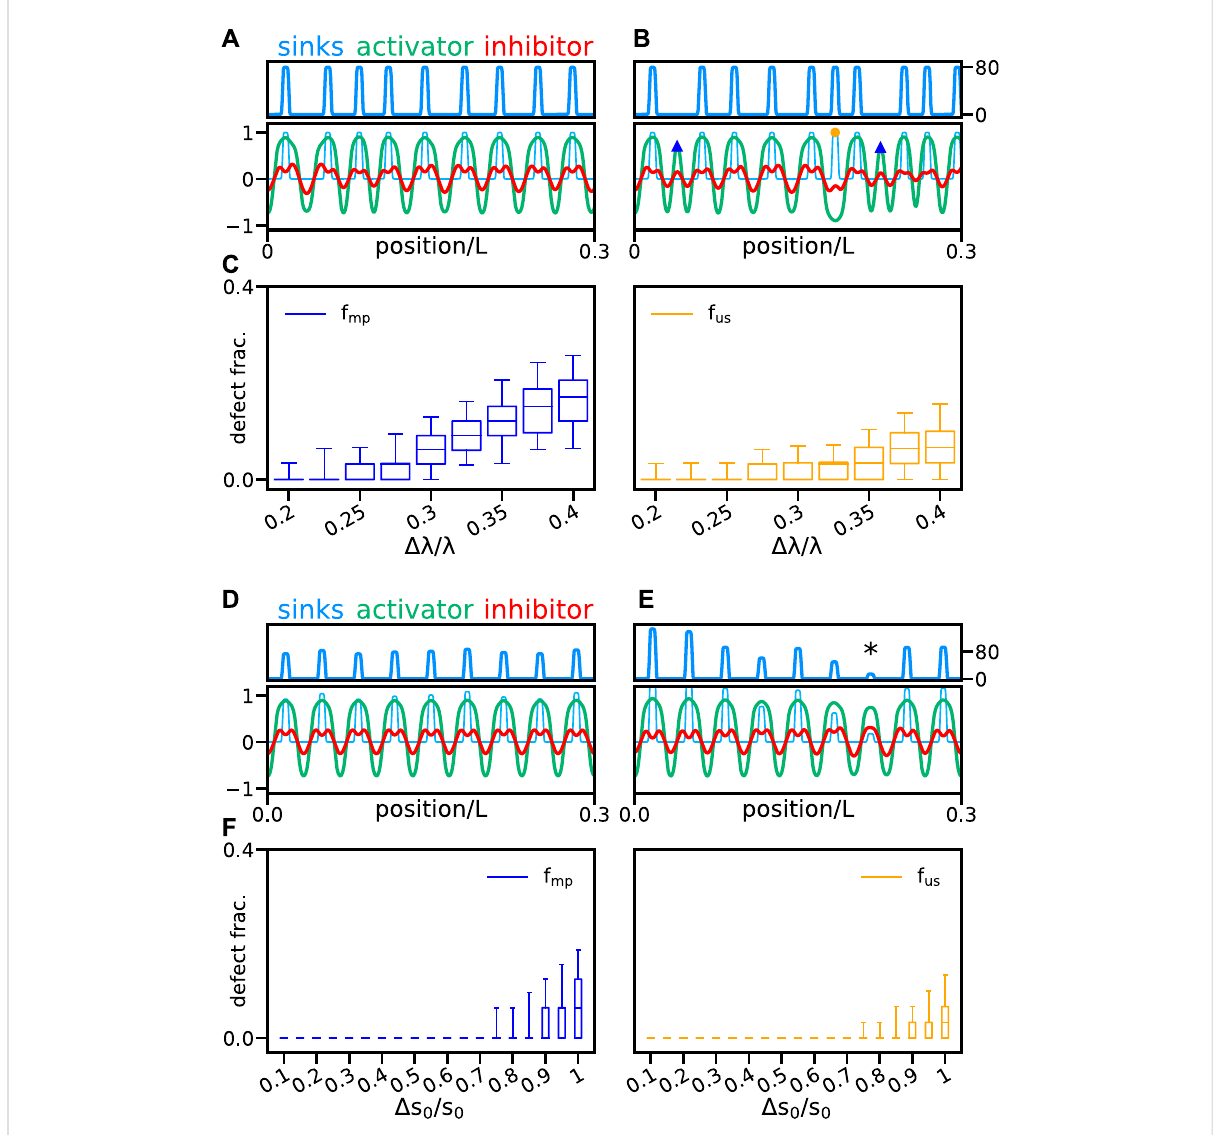
FIGURE 7 Fluctuations in sink position and strength. Activator (green line) and inhibitor (red line) patterns together with the scaled sink pro fi le (faint light blueline)areshownforsinkpro fi leswithrelativesinkposition fl uctuationamplitudes (A) Δ λ / λ =0.2and (B) Δ λ / λ =0.4.Wechooseameanwavelength λ =0.57,so λ / λ ≈ 1.43isclosetothecenterofthedefectfreeregioninFigure6C.Sinkpro fi le(lightblueline)isalsoshownseparatelyinthetoppanels 0 for clarity. (C) Fraction of misplaced peaks f mp (blue box plot) and unmatched sinks f us (orange box plot) vs. relative sink position fl uctuation amplitudes Δ λ / λ . Activator and inhibitor patterns for sink pro fi les with relative sink strength fl uctuation amplitudes (D) Δ s 0 / s 0 = 0.1 and (E) Δ s 0 / s 0 = 1, with mean sink strength s 0 = 80. Color coding and plot layout are as in panels (A and B) . (E) Asterisk marks a sink of strength s 0 ≈ 15. (F) Fraction of misplaced peaks f mp (blue box plot) and unmatched sinks f us (orange box plot) vs. relative sink strength fl uctuation amplitude Δ s 0 / s 0 . Box plots in (C) and (F) are as in Figure 4. Other parameters are as in Table 1. In all cases, we performed 300 realizations for each parameter